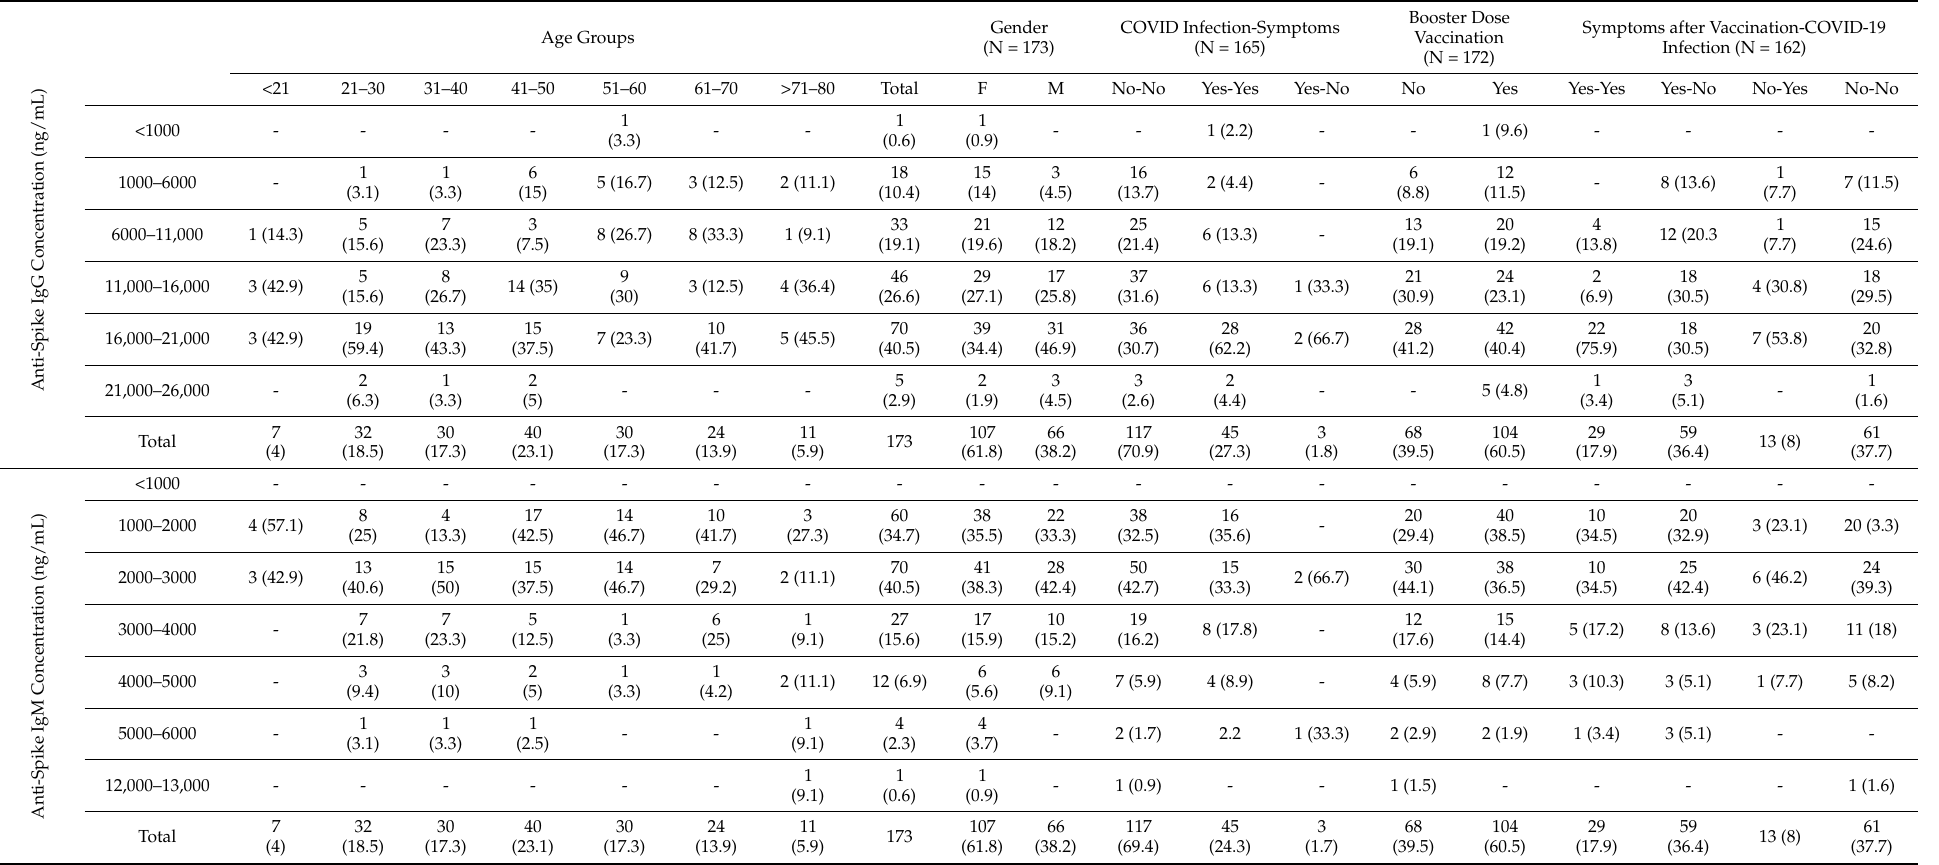
Table 5. Effect of age, gender, vaccination status, history of laboratory-confirmed SARS-CoV-2 infection on anti-spike IgM and IgG antibody levels measured in healthcare workers [quantitative data are presented as number